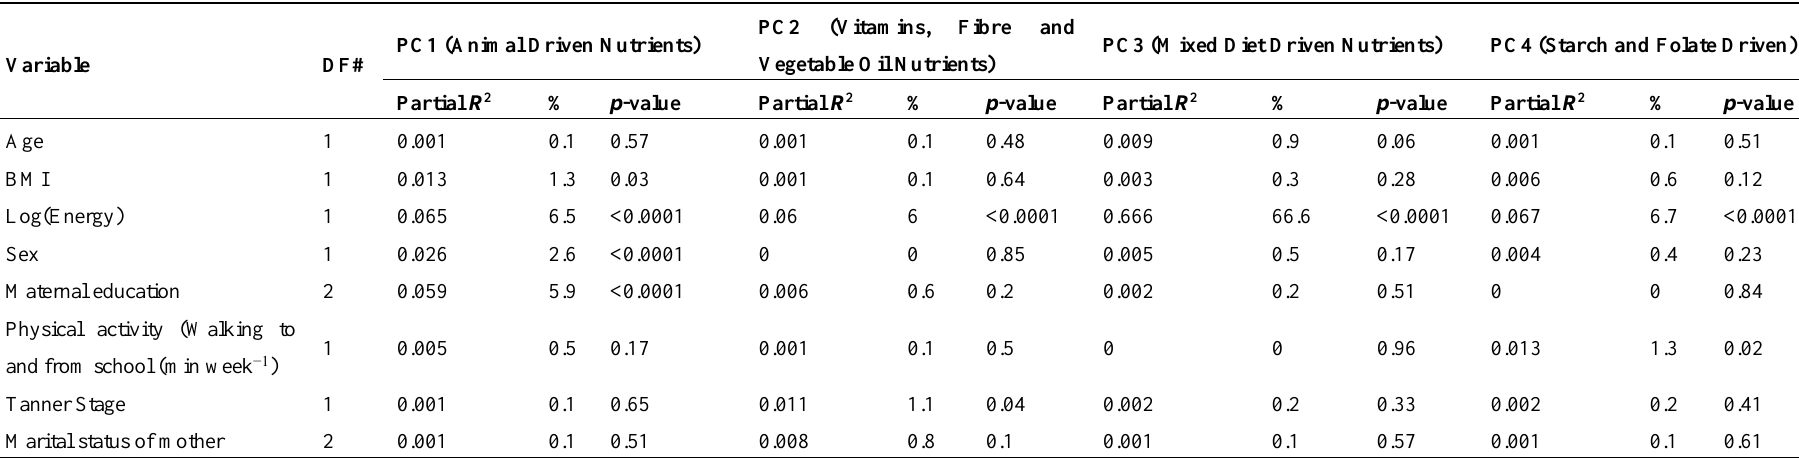
Table 3. p -Values of F -test on type III sum of squares